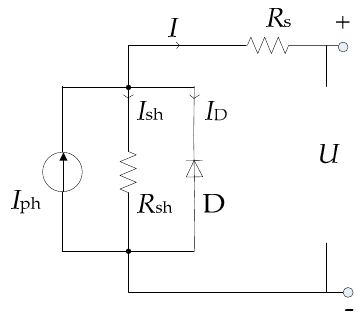
Figure 1. The equivalent circuit model of photovoltaic module.